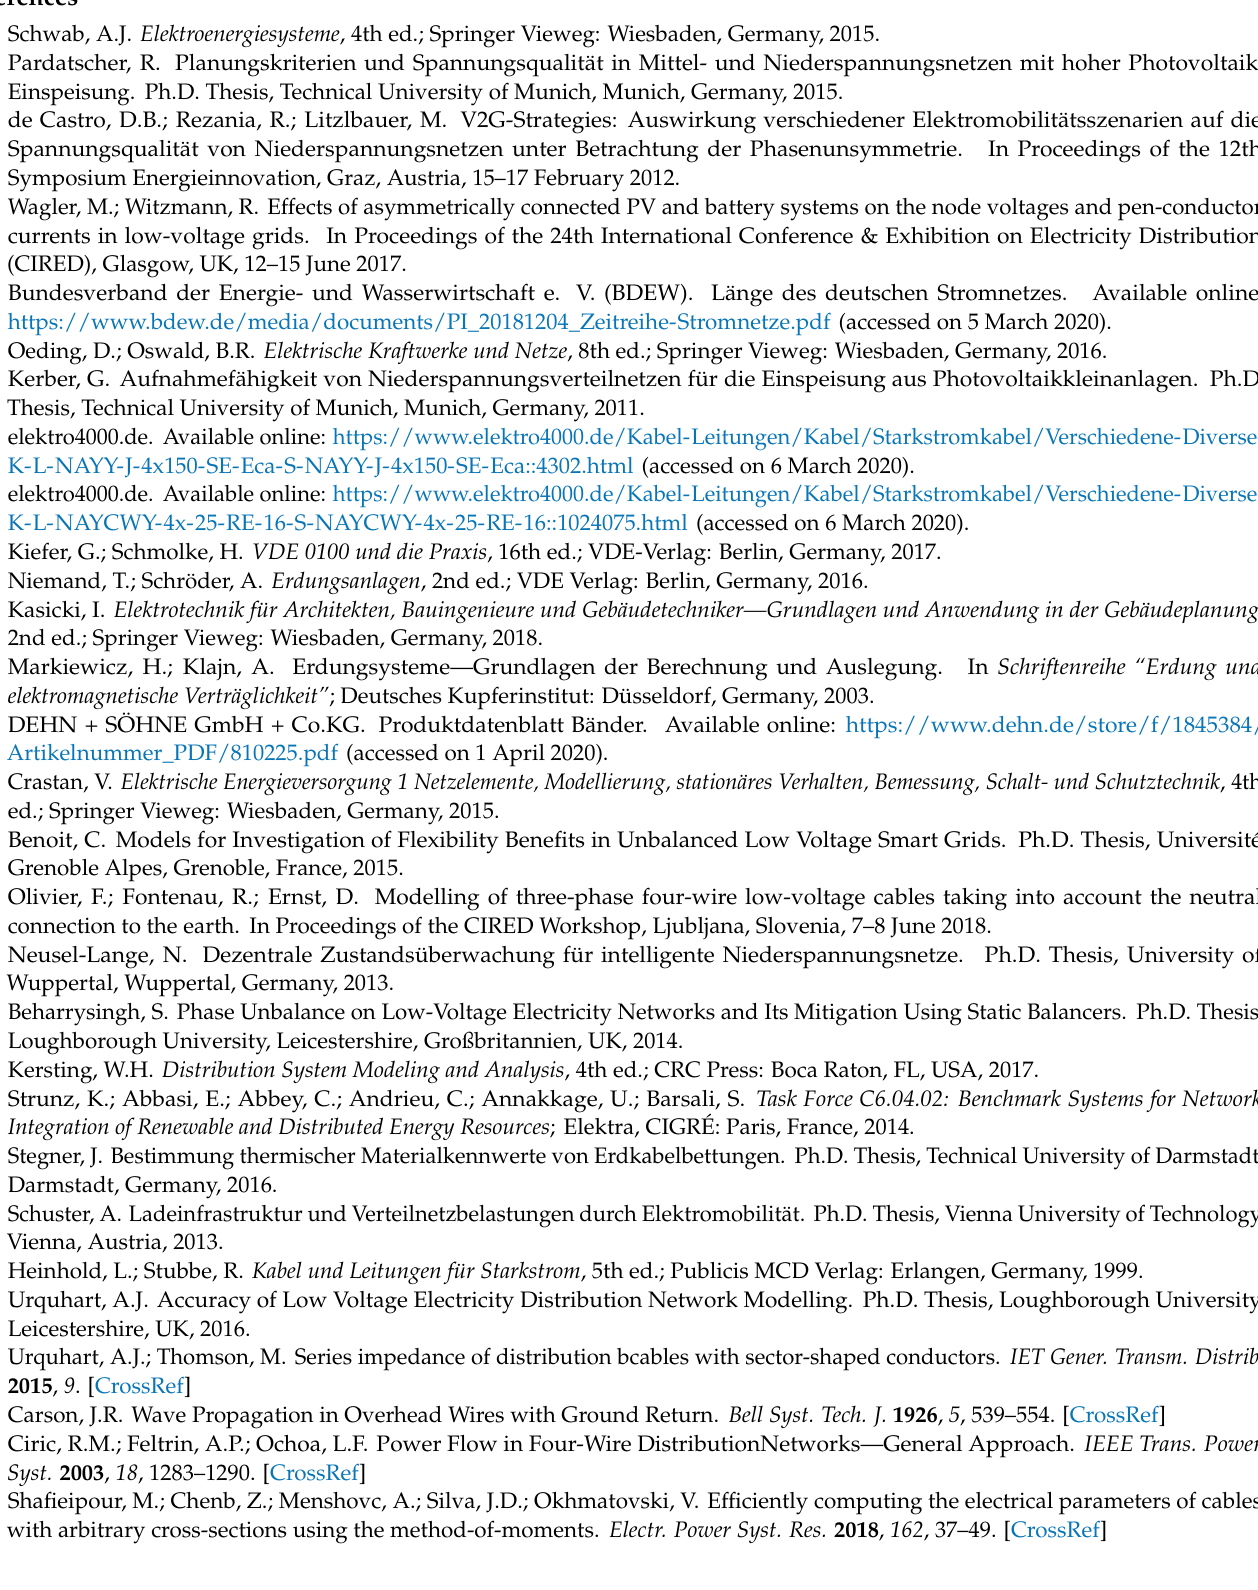
Indicated ranges in Table A1 reflect tolerances given for d and d ins in standard [37], as well as uncertainties regarding the value of (cid:101) r,PVC (between 3 and 4 according to Ref. [24]). For the simulations and the sensitivity analysis in Section 6, we used the maximum